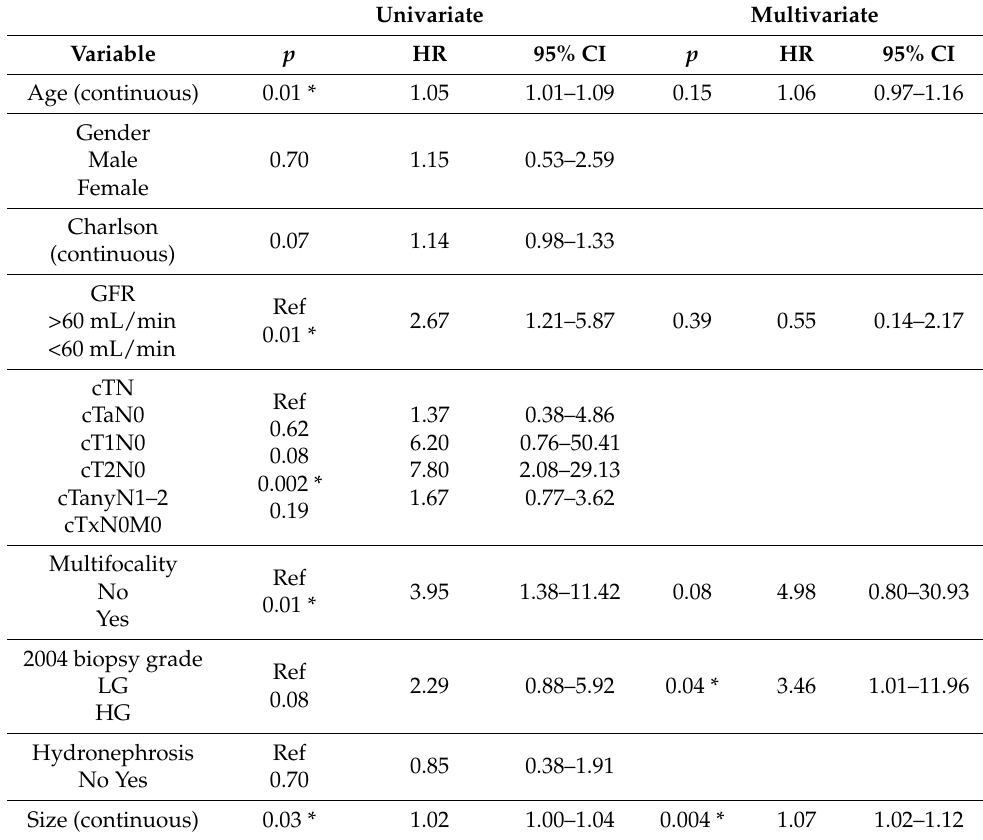
Table 3. Cox regression for factors associated with